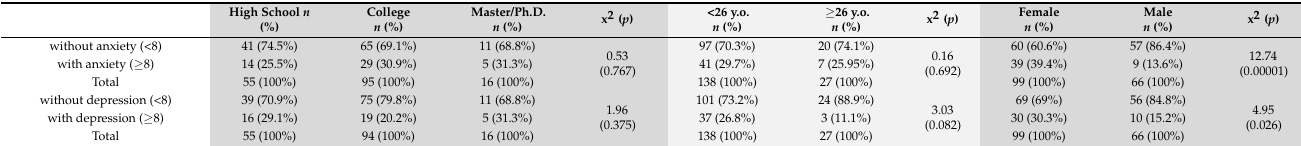
Table 8. Association between anxiety and depression and academic degree, age, and gender.